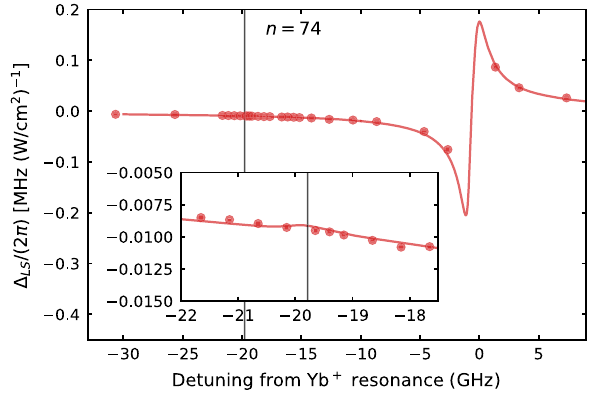
FIG. 5. The scaled light-shift curve using the MQDT-model parameters and Eq. B2 with data from the main text. Importantly, the MQDT model for the light shift does not predict a feature near the satellite lines ( n = 74 indicated with a black line). The inset shows an enlargement of the light shift near the shake-up resonance, where the MQDT model predicts a minor structure, indicating that the light shift is almost entirely dominated by the main autoionization transition.